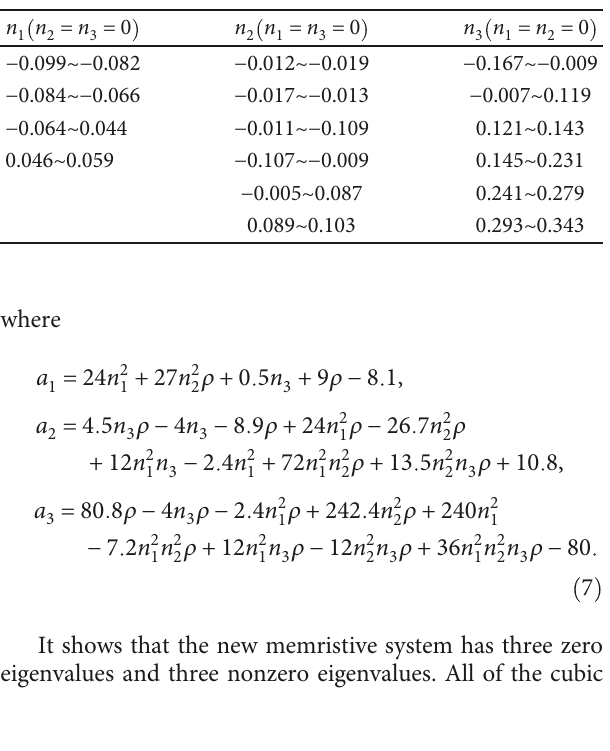
j = 1,2,3 ). (a) n n n j ( 1 varying (b) 2 varying (c) 3 varying. Table 1: Chaos ranges with di ff erent initial